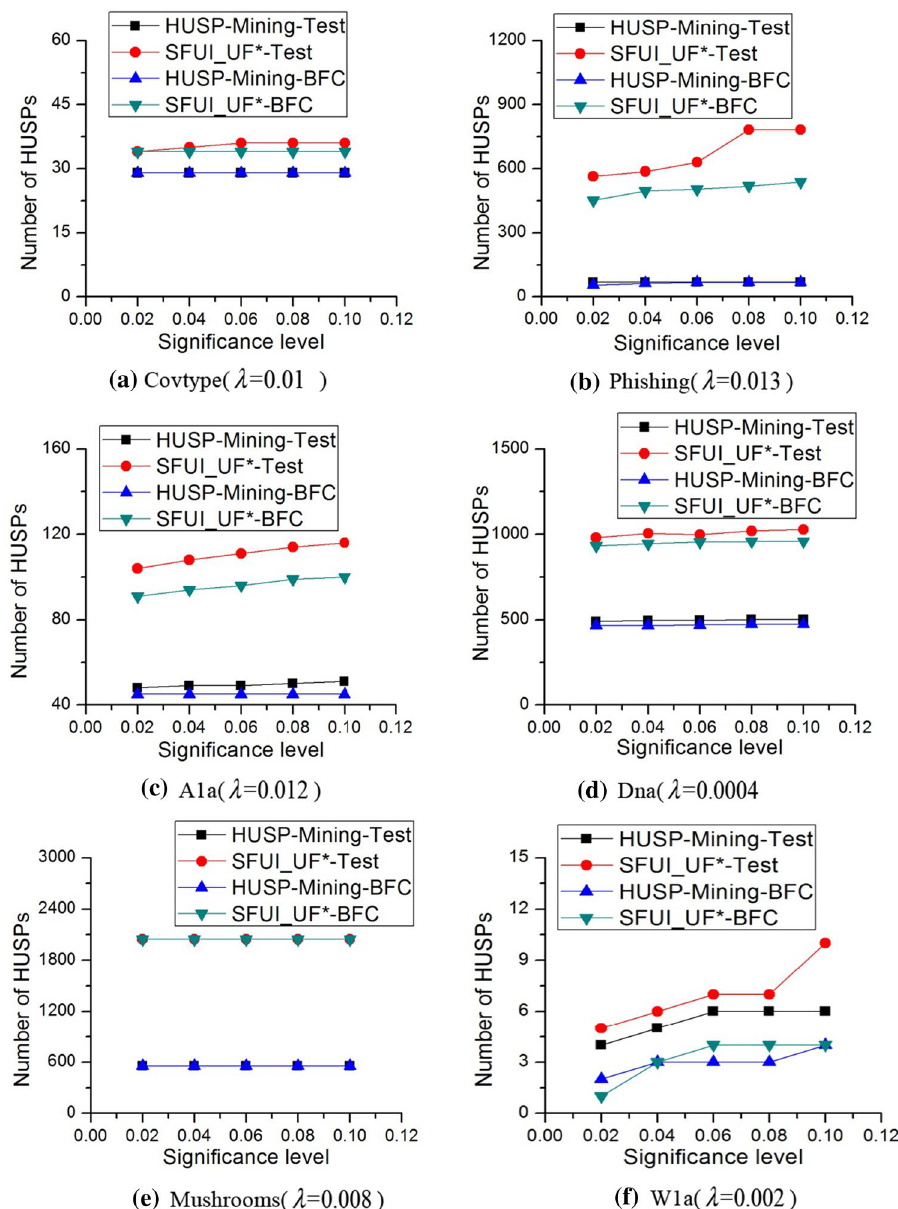
Fig. 14 The effect of the